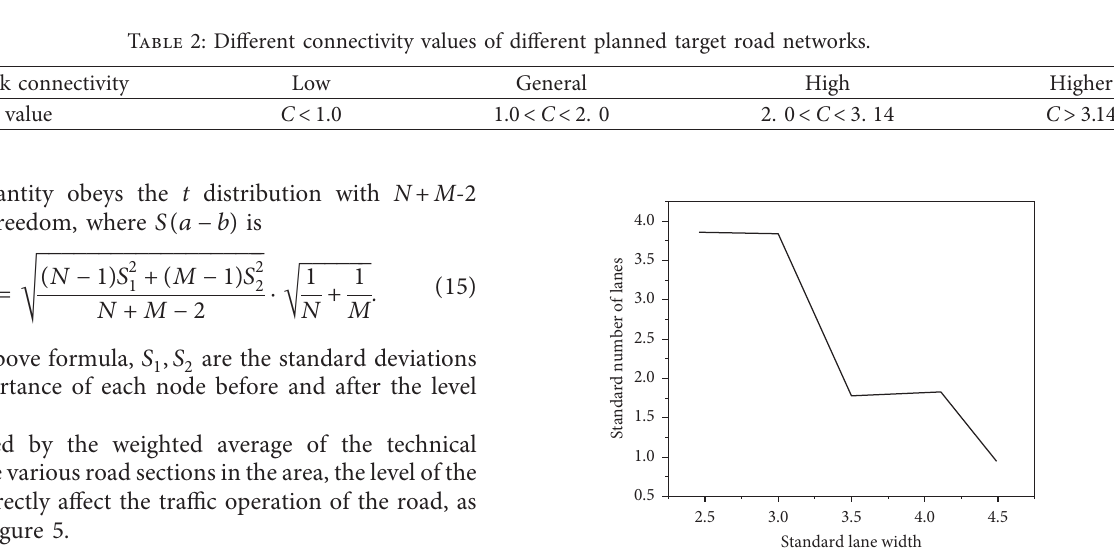
Figure 5: The number of standard lanes and lane widths for each class of